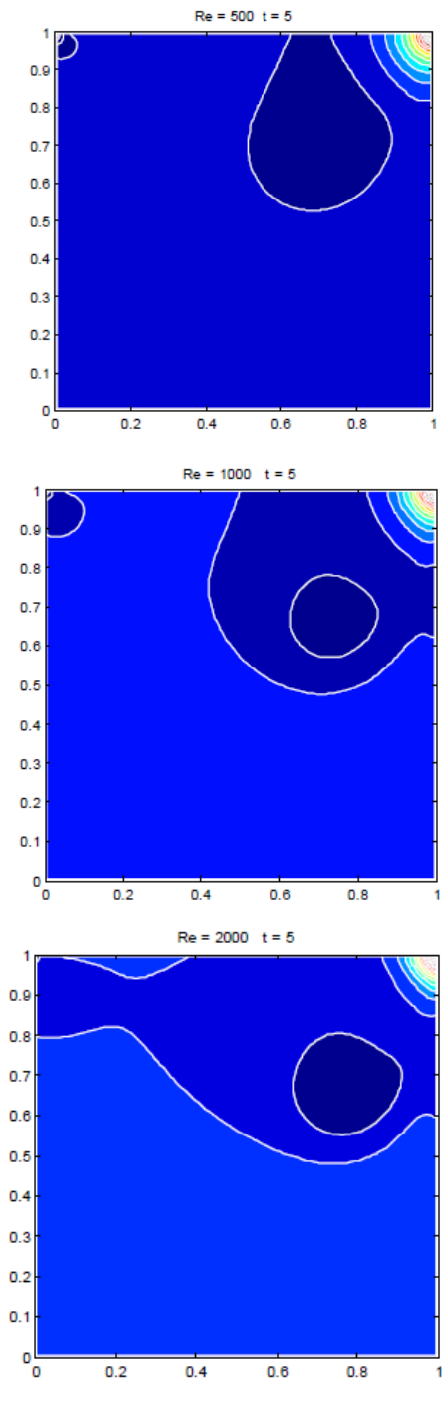
Figure 5. Pressure at t =5 sec for different values of